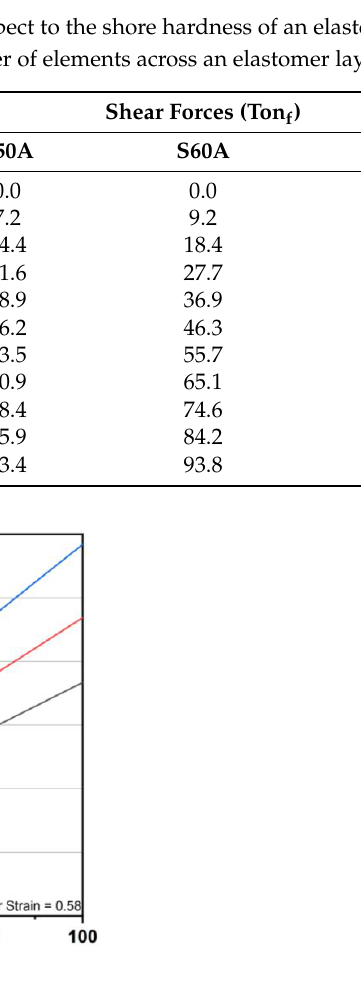
Figure 15. Shear force-displacement graph with respect to the shore hardness of an elastomer through the numerical simulation (FEA). The thickness of elastomer in this specimen (T q ) is 130 mm. Table 11. Shear forces and shear modulus of the elastomeric bearing with respect to the shore hardness of an elastomer through the numerical simulation (FEA).